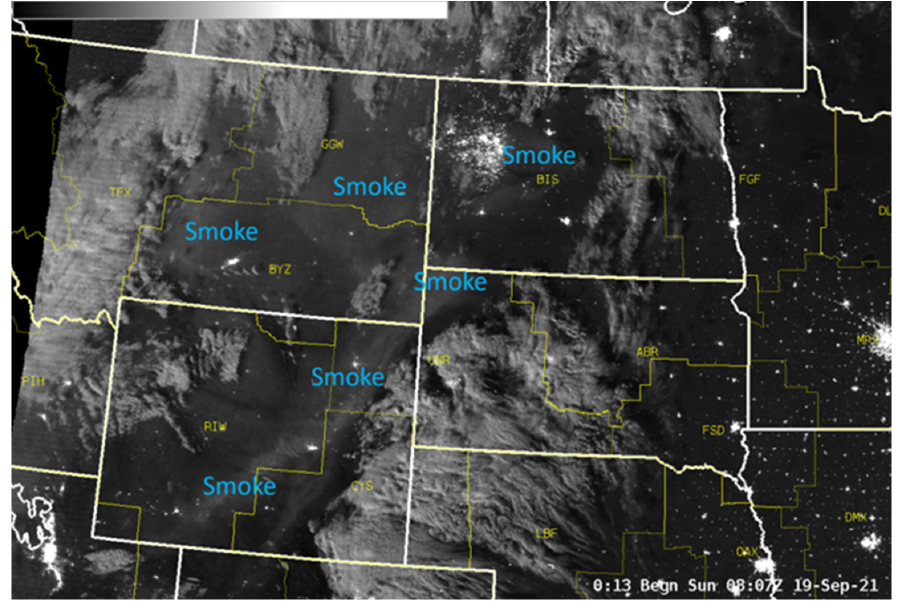
Figure 9. Operational example (19 September 2021) shares how NWS/BIS forecasters leveraged VIIRS NCC product for detecting wildfire smoke at night. See https://satelliteliaisonblog.com/2021/09/20/viirs-ncc-use-for-nighttime-smoke-detection/ accessed on 4 April 2022.